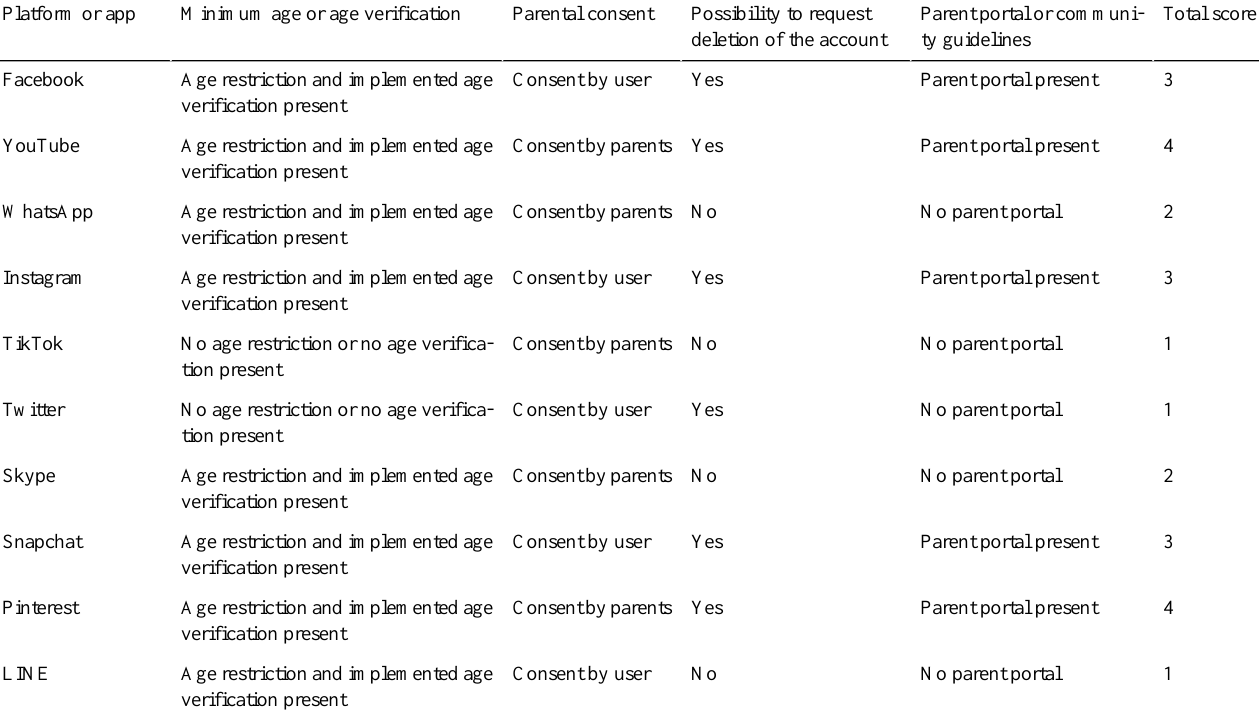
Table 2. Scoring the most popular social media apps.